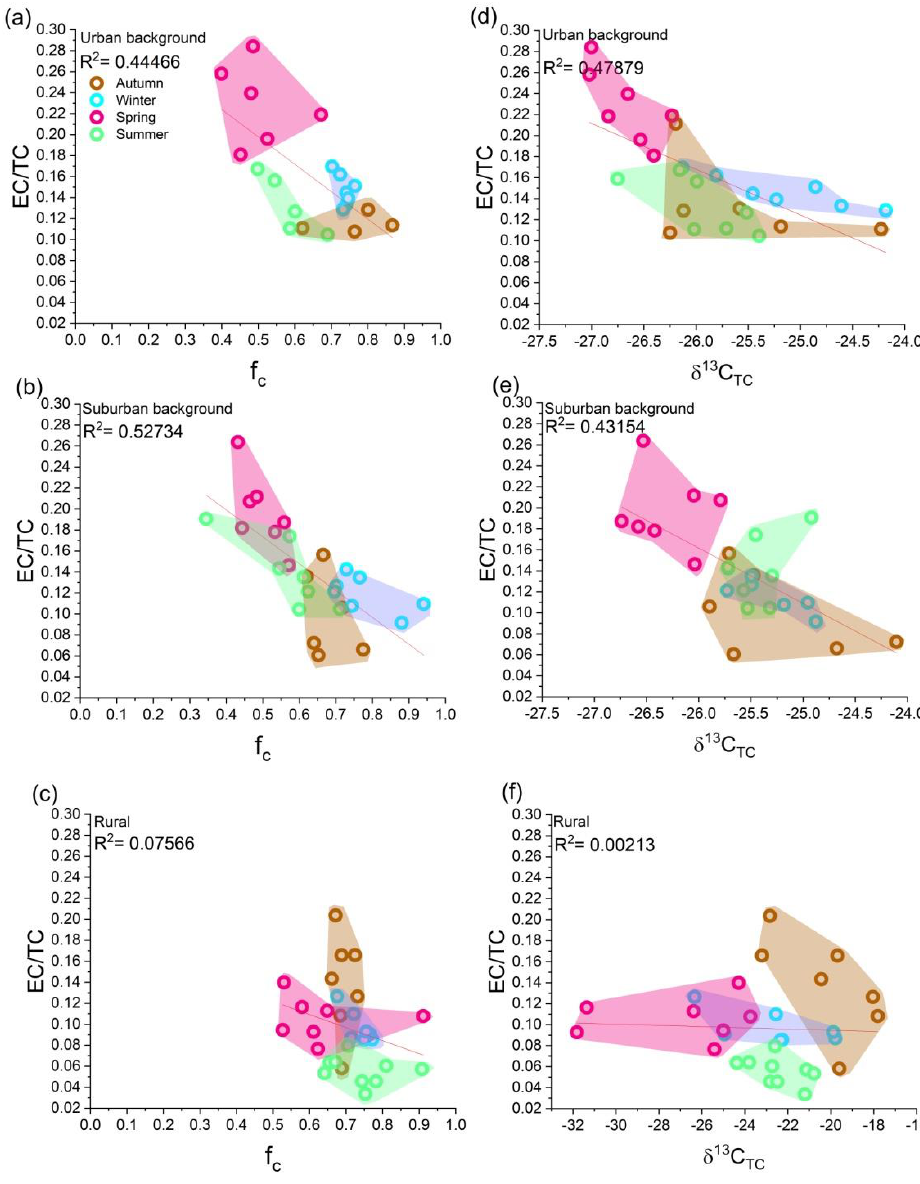
Figure 5. Seasonal clusters of the EC/TC values depicted as a function of f C ( a – c ), and δ 13 C ( d – f ) values at the urban background, suburban background and rural sites .